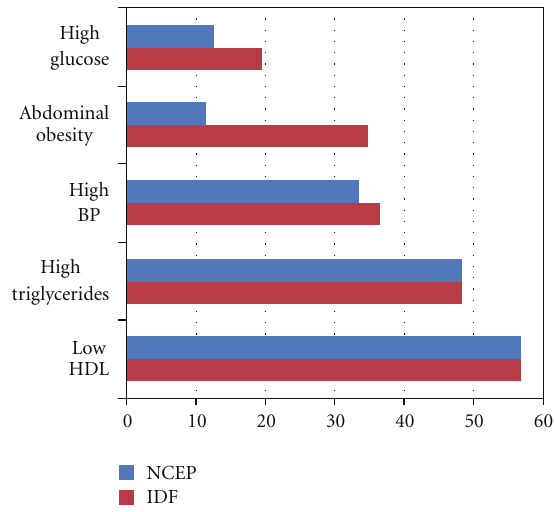
Figure 1: Percentage of traits of metabolic syndrome in the total